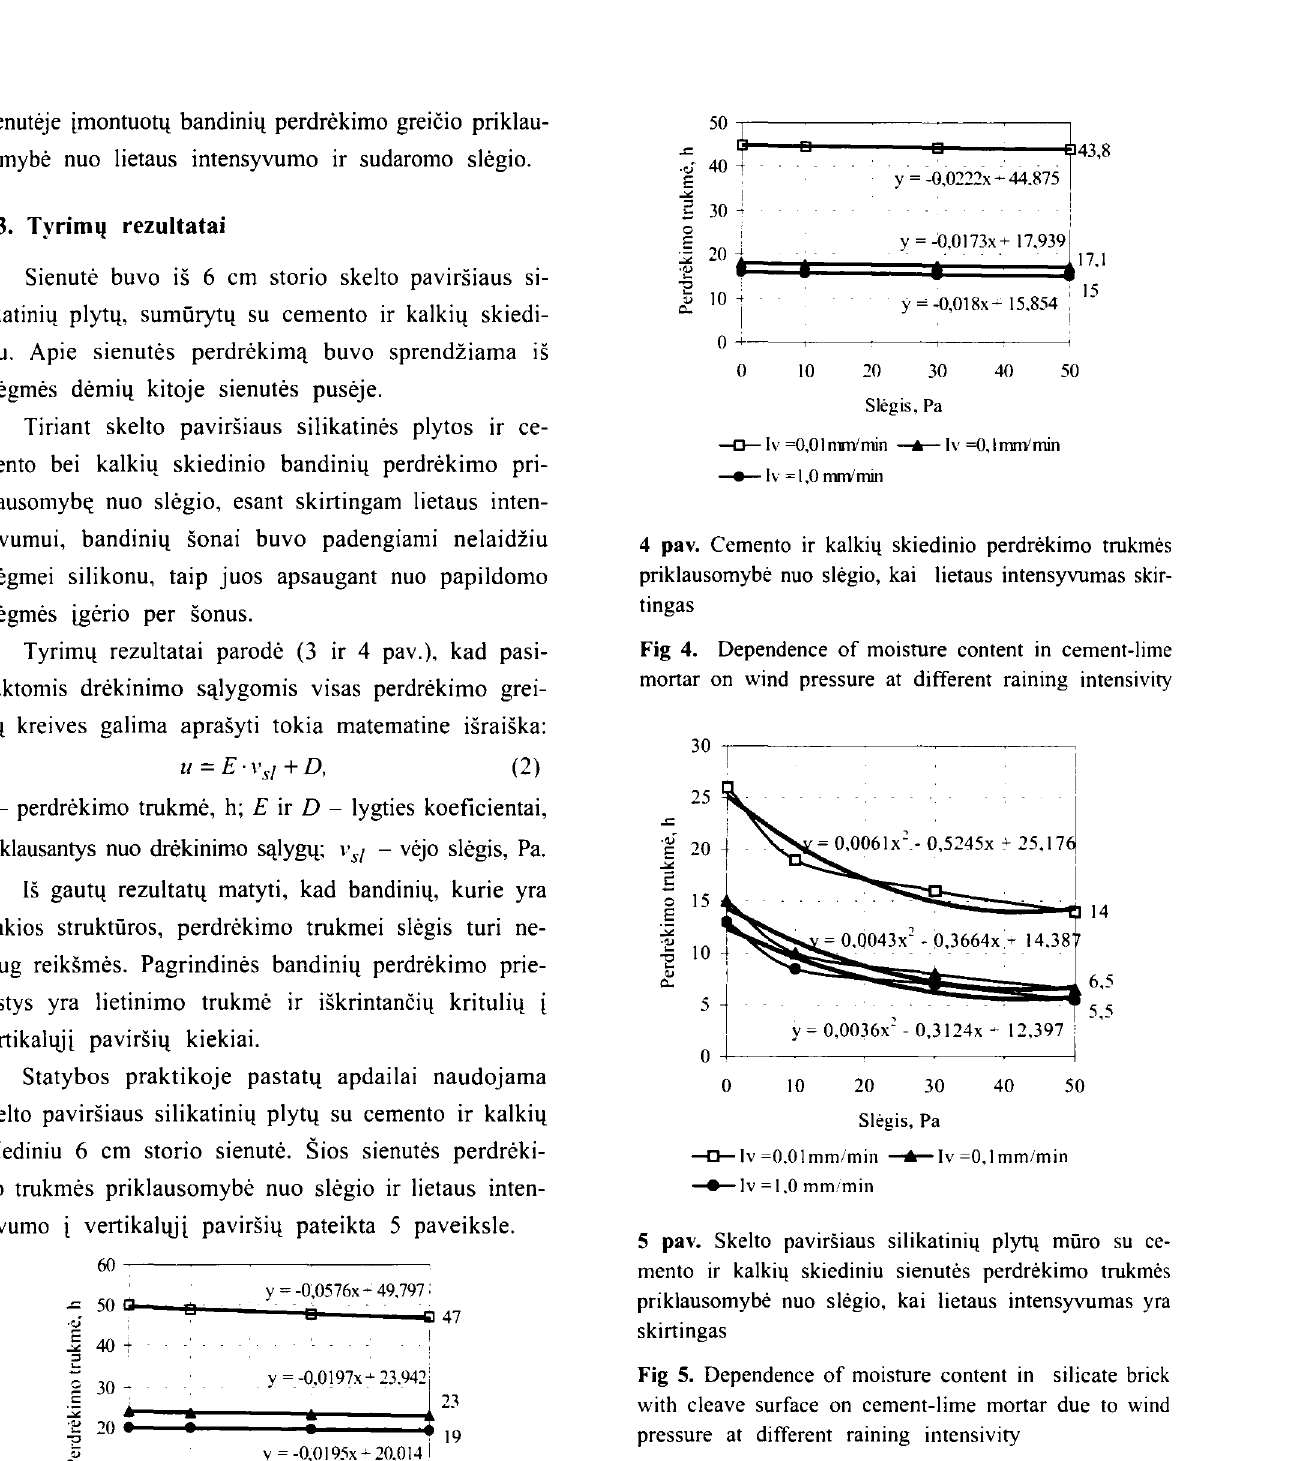
Fig 3. Dependence of moisture content in silicate brick with cleave surface on wind pressure at different rai ning intensivity